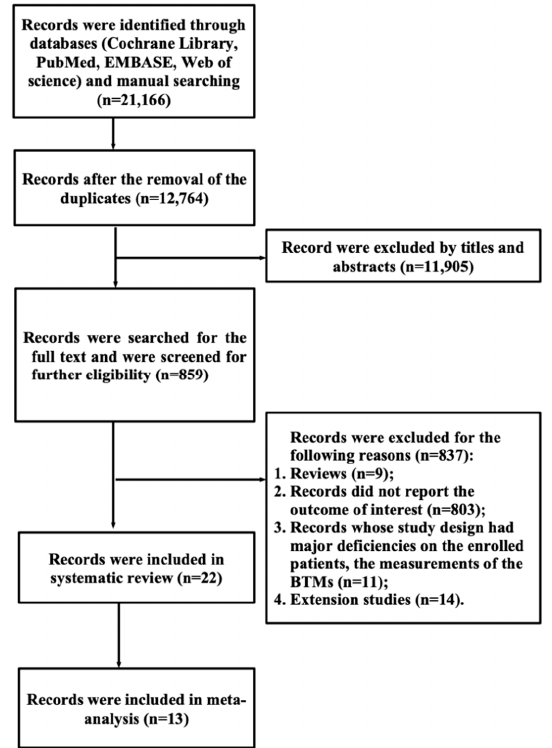
Figure 1. Flow chart of the literature search and study selection.